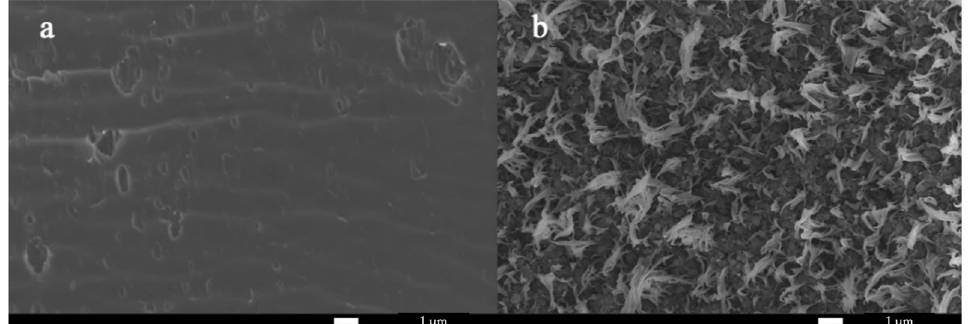
Figure 7. SEM image of cross section of ( a ) bare PVDF-SSS membrane, ( b ) composite membrane.